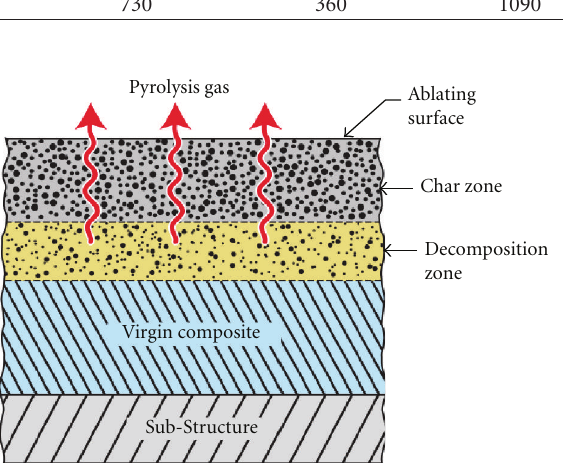
Figure 18: Decomposing